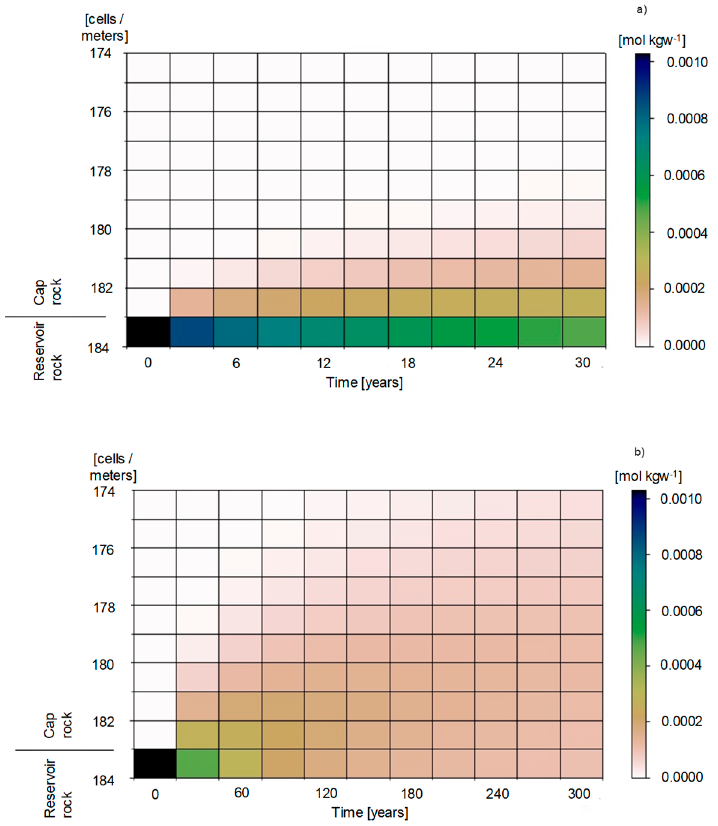
Figure 4. Diffusion of a non-reactive hydrogen tracer through the cap rock over ( a ) 30 years and ( b ) 300 years.